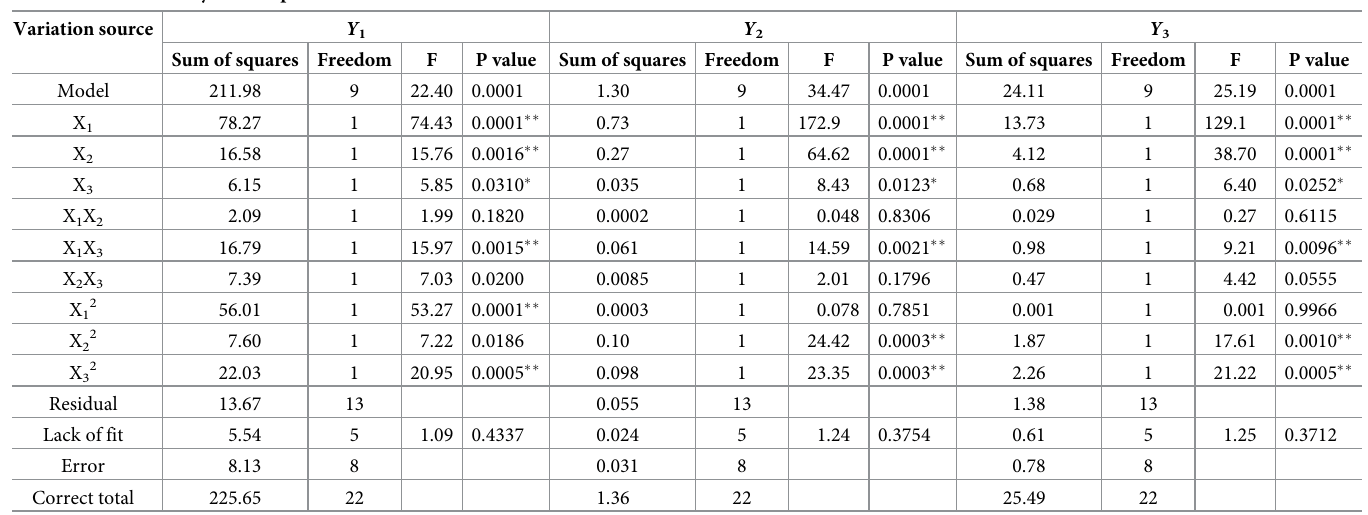
Table 4. Variance analysis of response surface